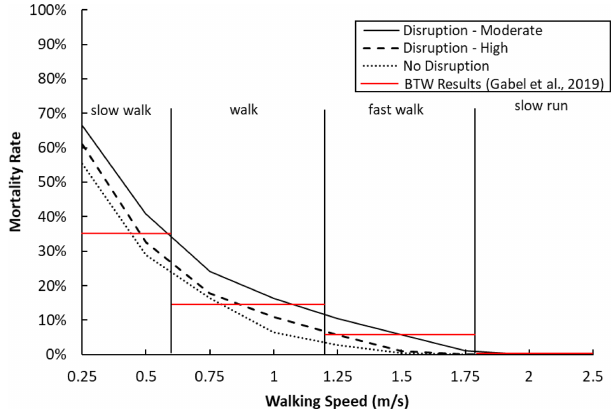
Figure 9. Network disruption impact: ABMS and BtW model result